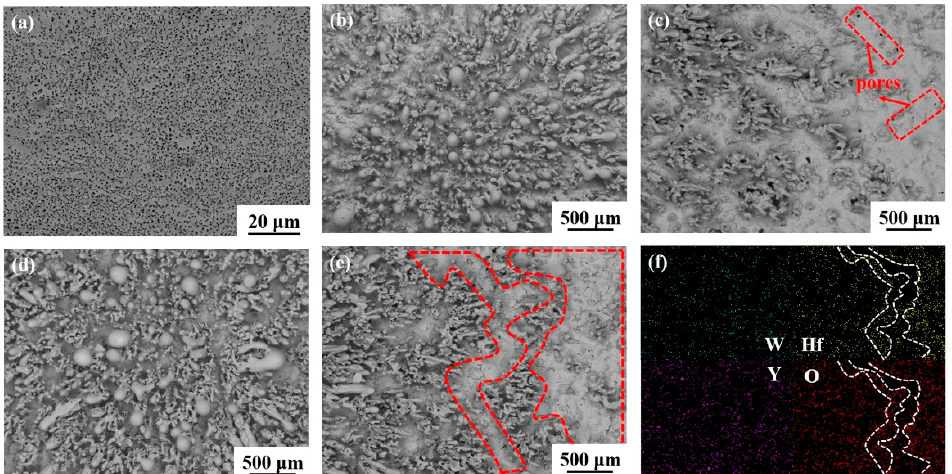
Figure 5. SEM images of the ablated surface. ( a ) Microstructure of W-1.5 Y. ( b ) Central area of ab- lated W-1.5 Y-10 Hf. ( c ) Surrounding area of ablated W-1.5 Y-10 Hf. ( d ) Central area of ablated W- 1.5 Y-20 Hf. ( e ) Surrounding area of ablated W-1.5 Y-20 Hf. ( f ) EDS analysis of the element